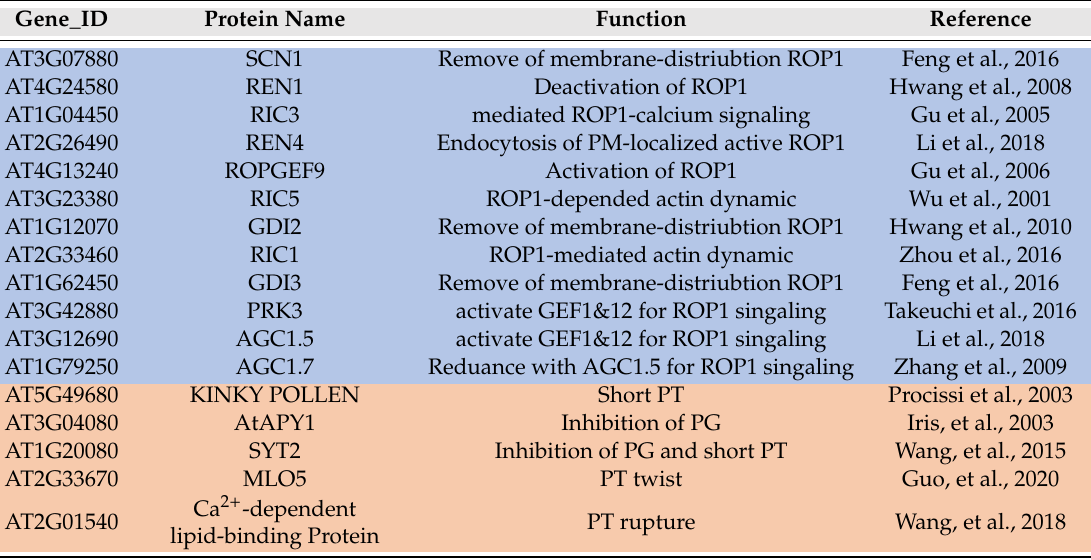
Table 1. The identified reported ROP1 interactors and pollen tube regulators identified in the